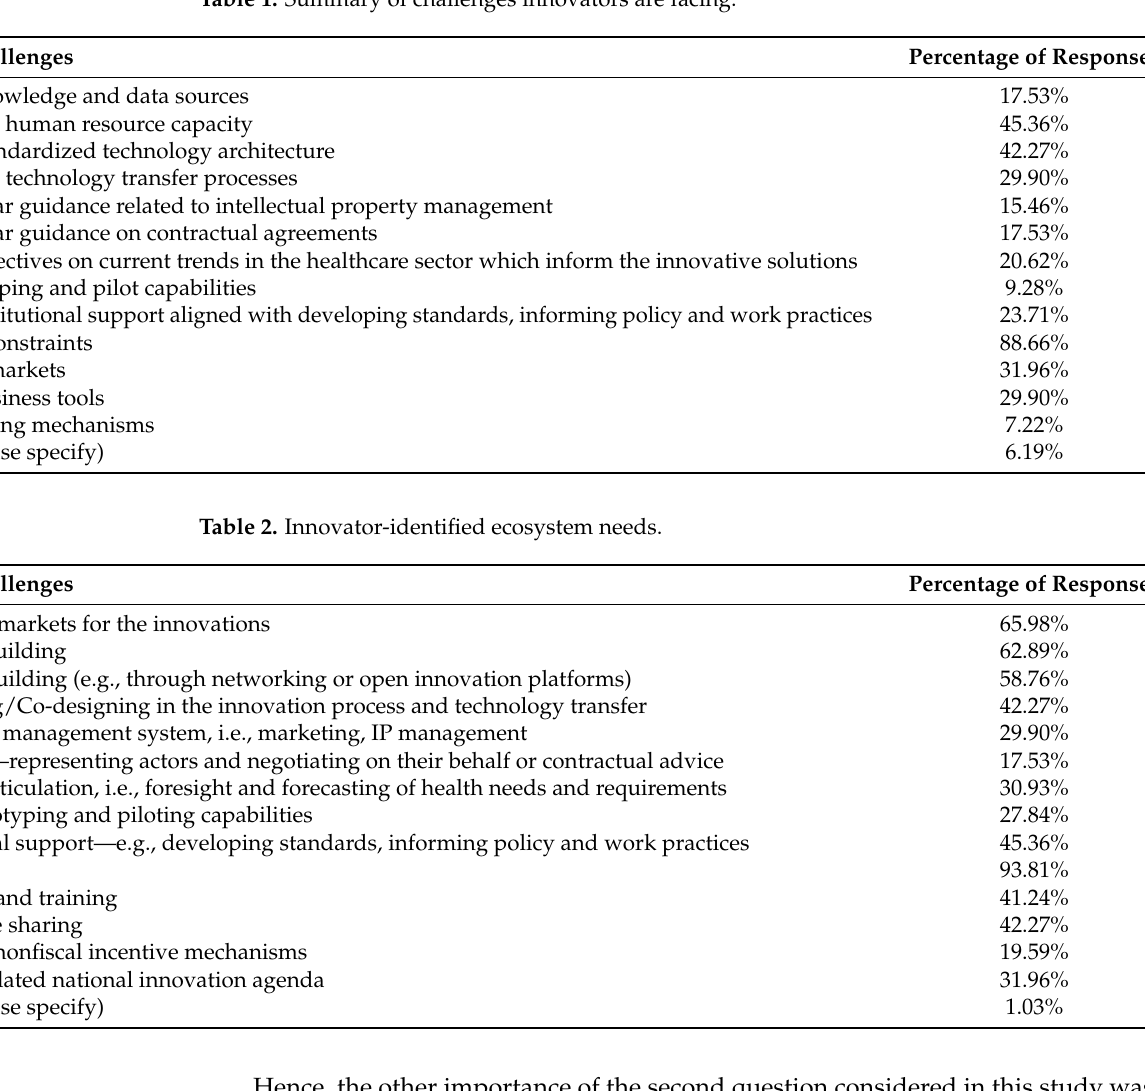
Table 1. Summary of challenges innovators are facing.